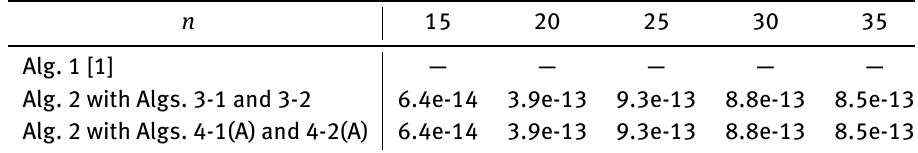
Table 10: Relative errors in (20) between the approximate minimum singular value of T in Table 8 and the minimum singular value of T computed by svd . The superscript † indicates that the relative error in (20) equals